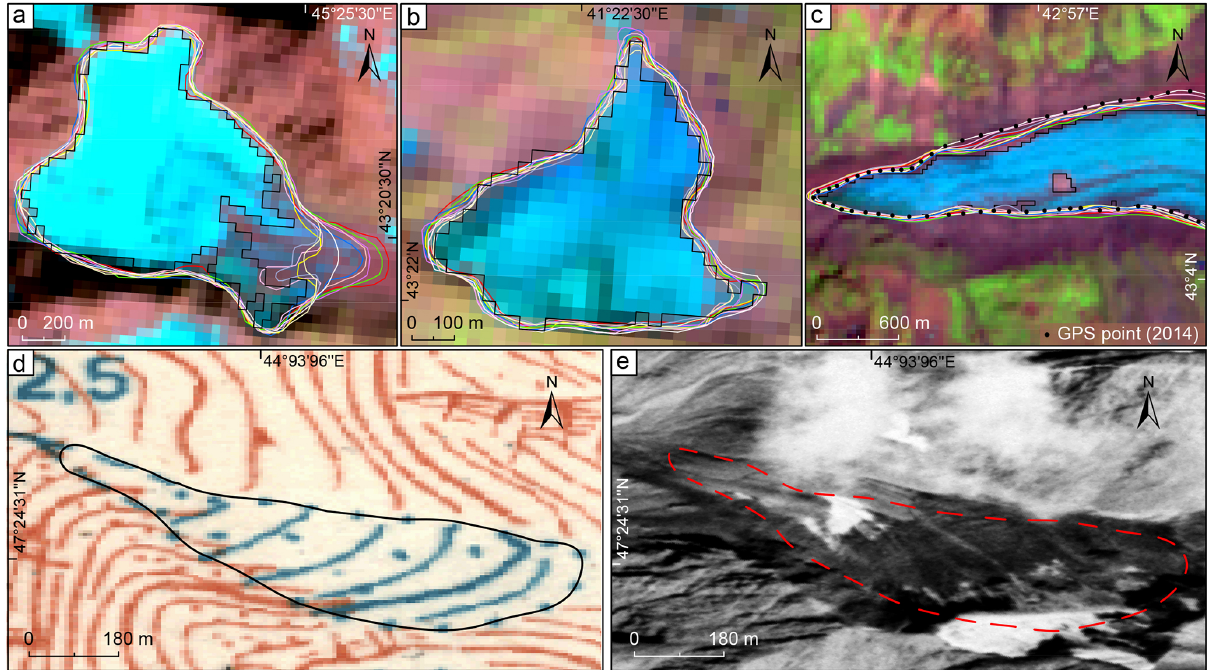
Figure 2. (a–c) Examples from the multiple digitizations of glaciers (bands 654 as RGB) using the OLI scene performed by different analysts (coloured lines). Black outlines refer to the automatically derived extents (4 / 6 ratio); pixel size is 30m. (d) Error in the 1960 map included mapped snow for small cirque type glacier; (e) 1964 Corona imagery of the same